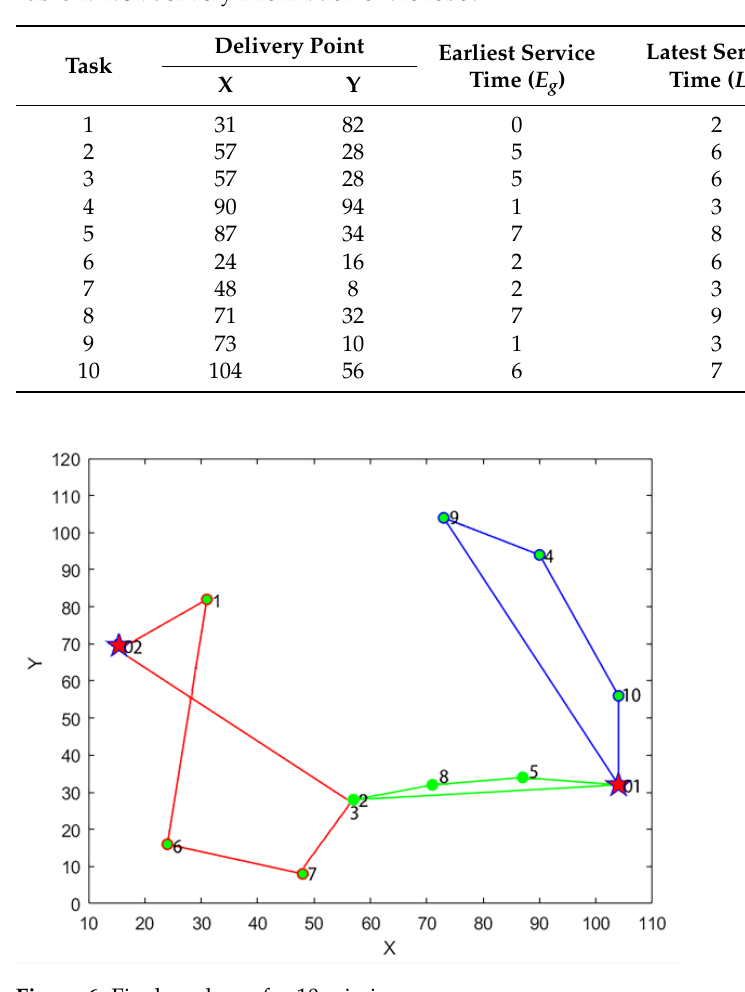
Table 1. Task delivery information of the robot. Table 2. Optimal schedule of SR.